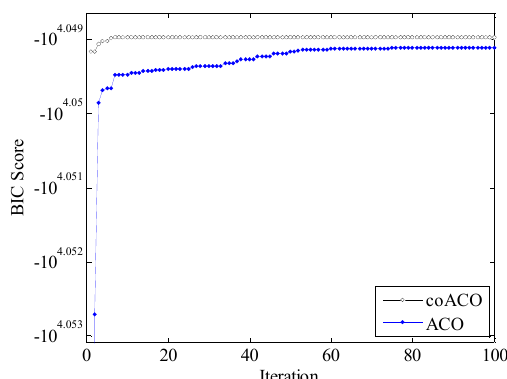
Figure 5. Evolution curves of the average BIC score achieved by ACO and coACO on the ASIA dataset with n = 3000.